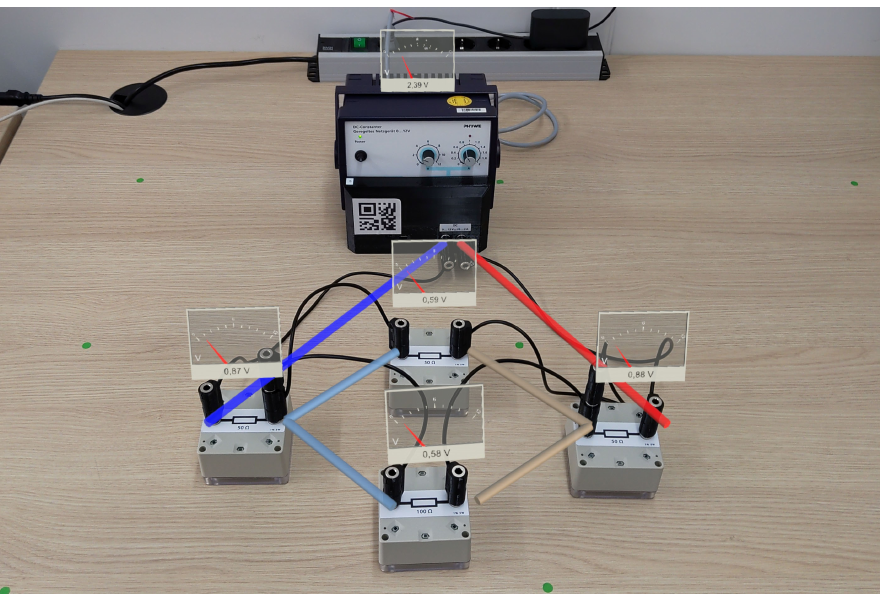
Figure 11. Example of a visualization of the electrical potential in the current circuit inspired by the electron gas model by Burde and Wilhelm